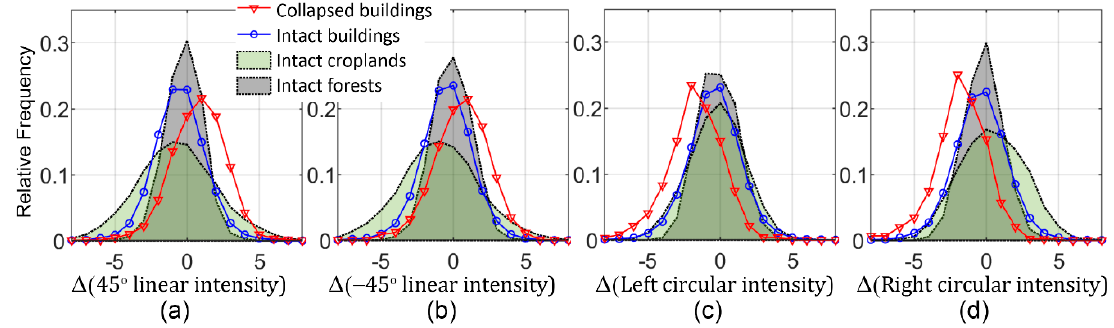
Figure 4. Histograms of scattering power changes at ( a ) +45° -linear, ( b ) −45° -linear, ( c ) left circular, and ( d ) right circular polarization states.